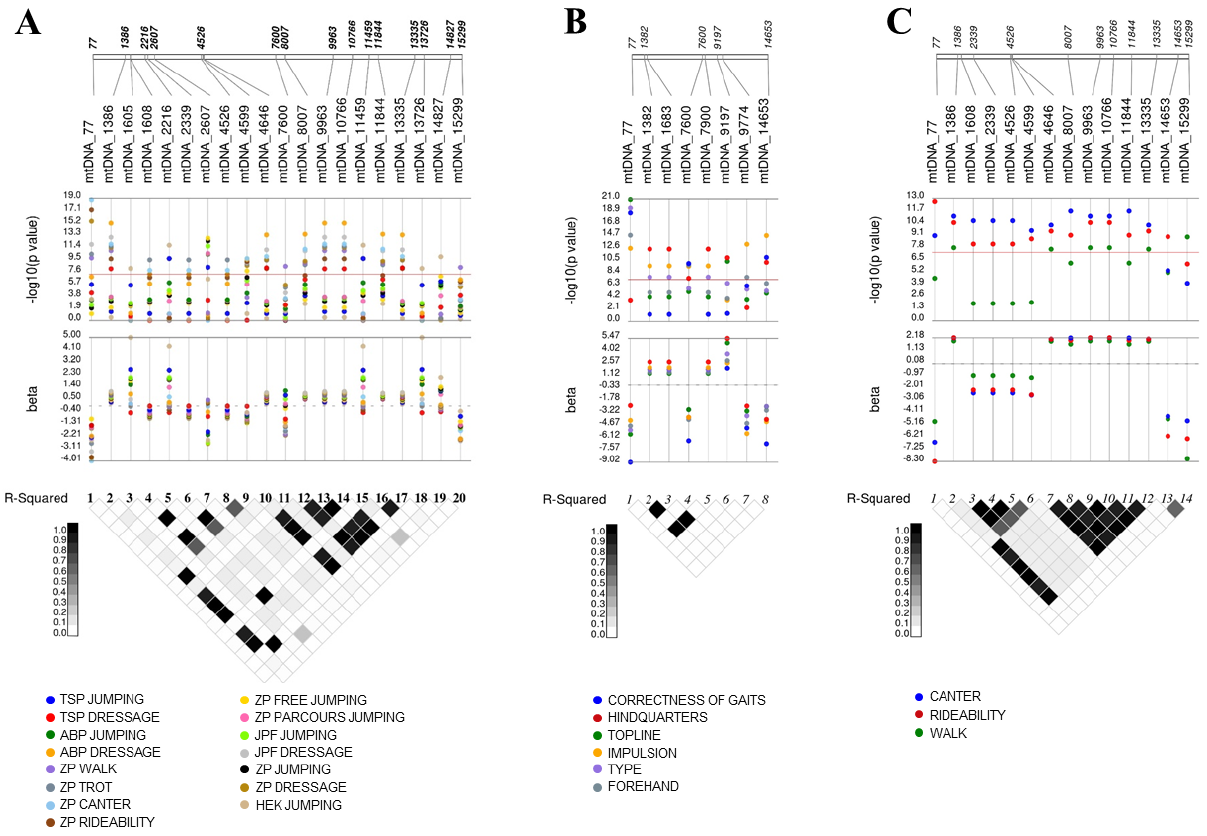
Figure 1. Mitochondrial SNPs significantly associated with breeding values. Association analyses were performed to identify mtSNPs associated with ( A ) FN breeding values, ( B ) breeding values for studbook inspection, and ( C ) breeding values for mare performance test. Only mtSNPs with p < 5 × 10 − 8 (indicated by the red line) are illustrated and are plotted according to their position on the mitochondrial genome. The values for the different traits are shown in different colors. LD between mtSNPs was measured as r 2 using Haploview software.